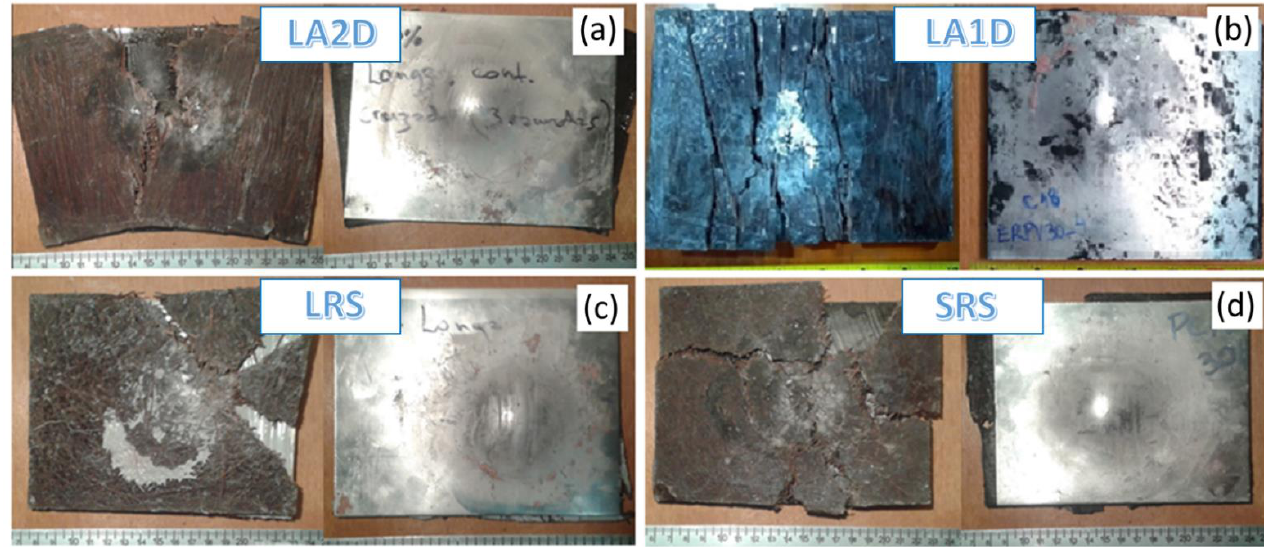
Figure 6. Front and back face of MASs ( a ) LA2D; ( b ) LA1D; ( c ) LRS, and ( d ) SRS.